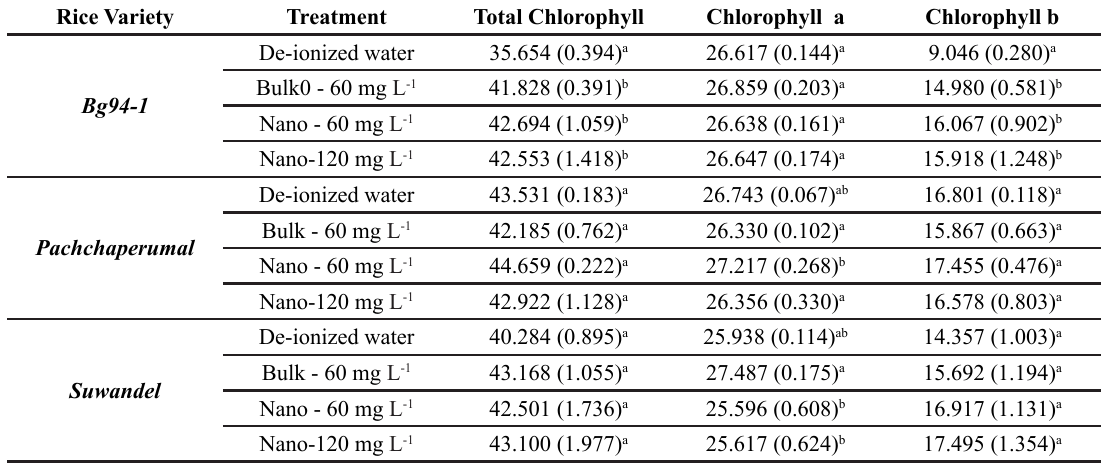
Table 2: Descriptive statistics of the parametric characteristics, total chlorophyll and chlorophyll a and chlorophyll b with treatment and rice variety